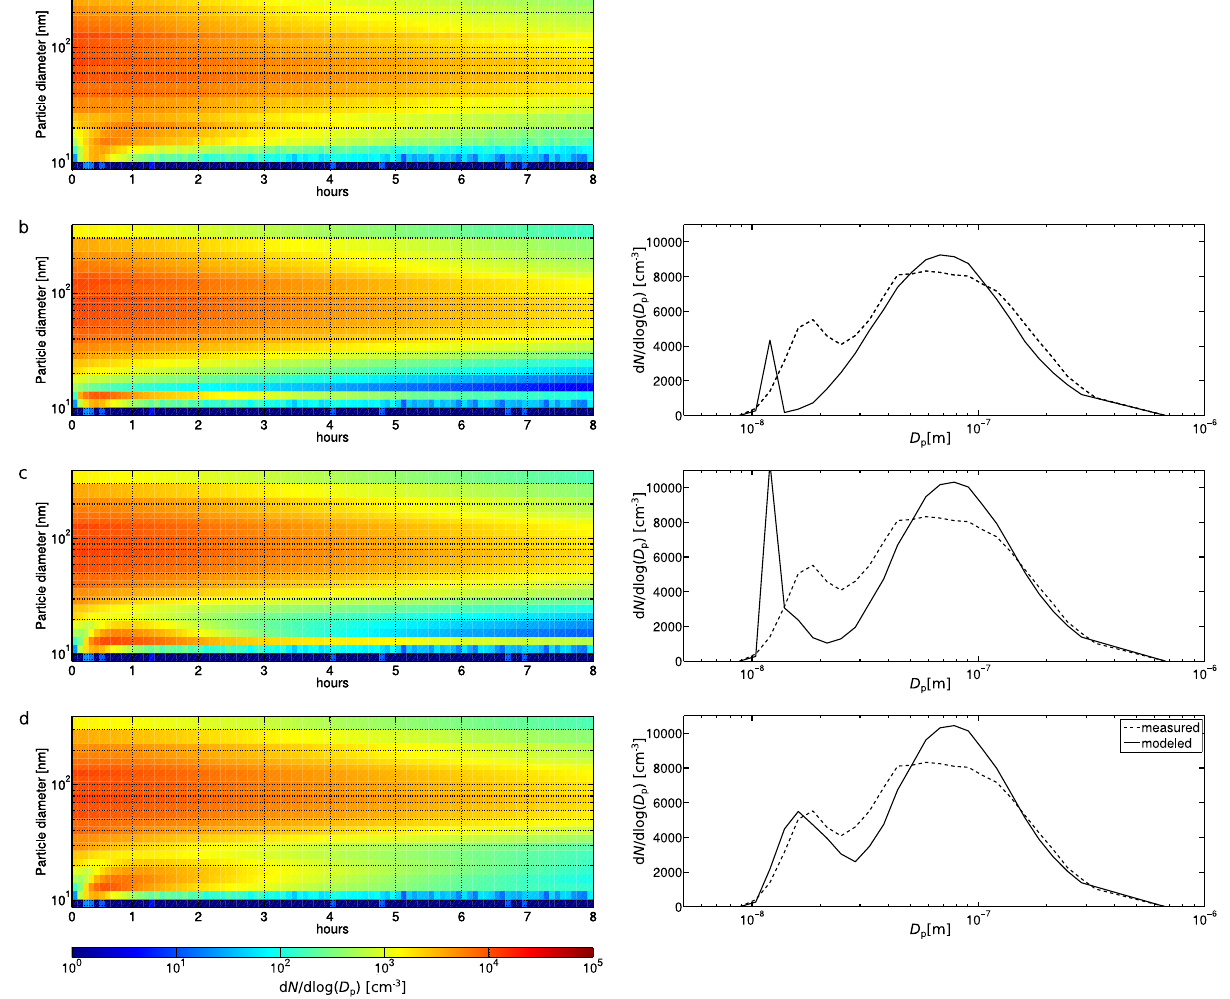
Fig. 4. (a) Observed evolution of aerosol size distribution, (b) modeled evolution of aerosol size distribution using stoichiometric coefficients given in Table 1, (c) modeled evolution of aerosol size distribution using optimized stoichiometric coefficient for the lowest volatility class, (d) modeled evolution of aerosol size distribution using optimized volatility and stoichiometric coefficient for the lowest volatility class. The right column includes a 2-dimensional size distribution of each simulation at 1.5h into the